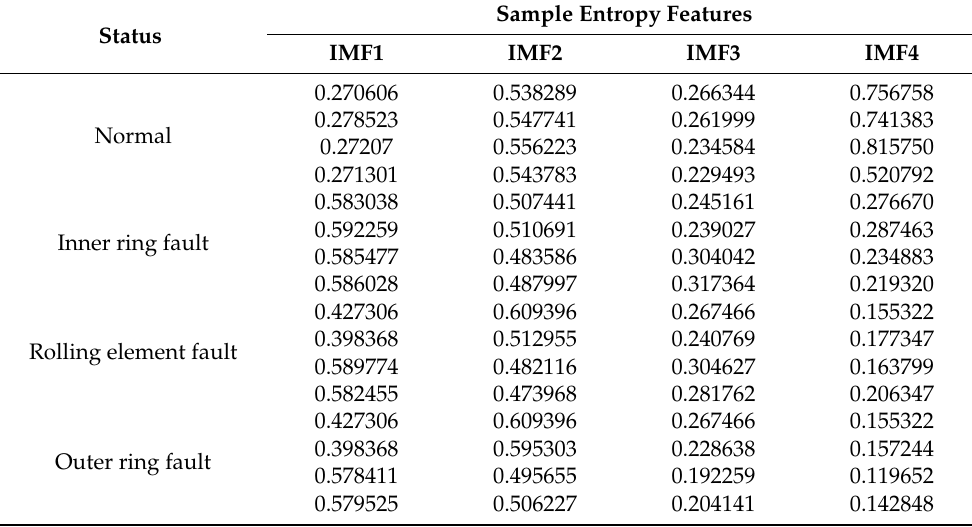
Table 2. Sample entropy of some